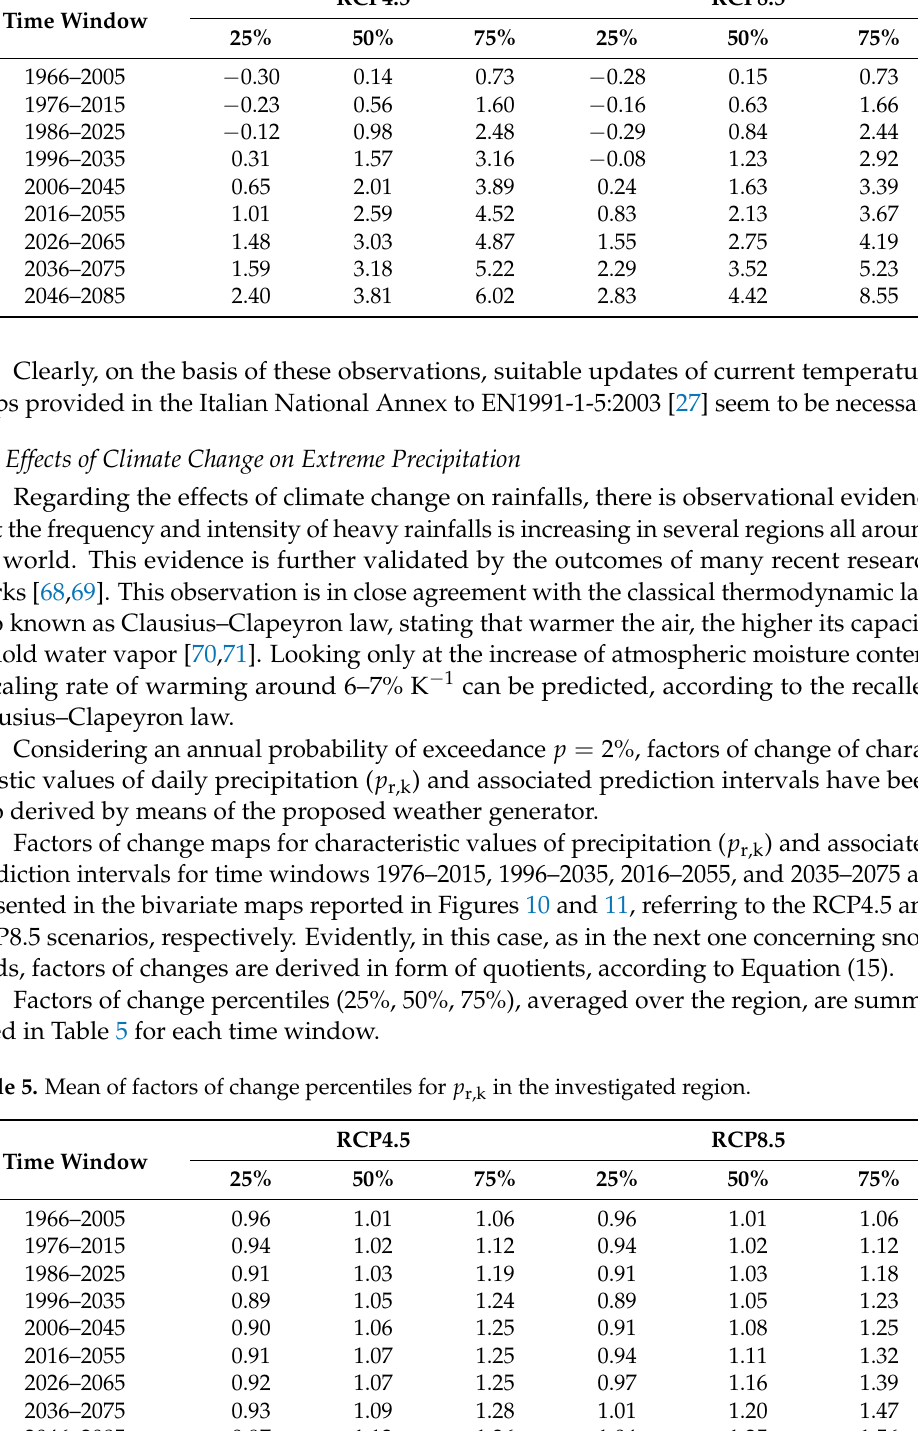
Table 4. Mean of factors of change ( ◦ C) percentiles for T Min,k in the study region. RCP4.5 Time Window